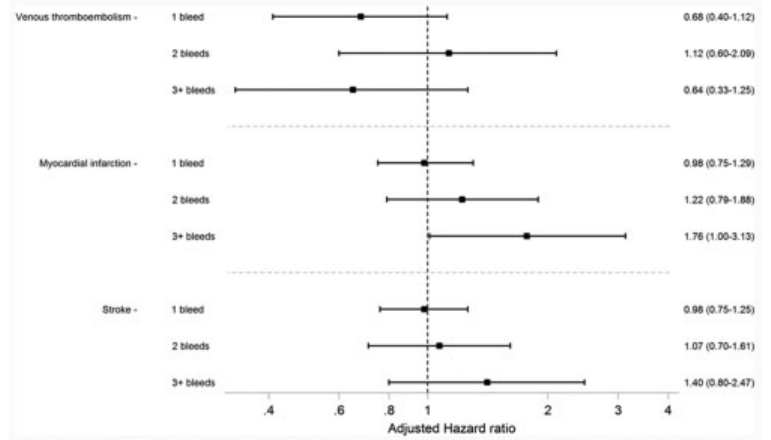
Fig. 4 Forest plot describing the hazard of secondary clinical outcomes during VKA treatment in the period following the fi rst, second, and third bleeds compared with the hazard in the period before any bleeds have occurred. Hazard ratios adjusted for all characteristics listed in ► Table 1 . VKA, vitamin K antagonist.